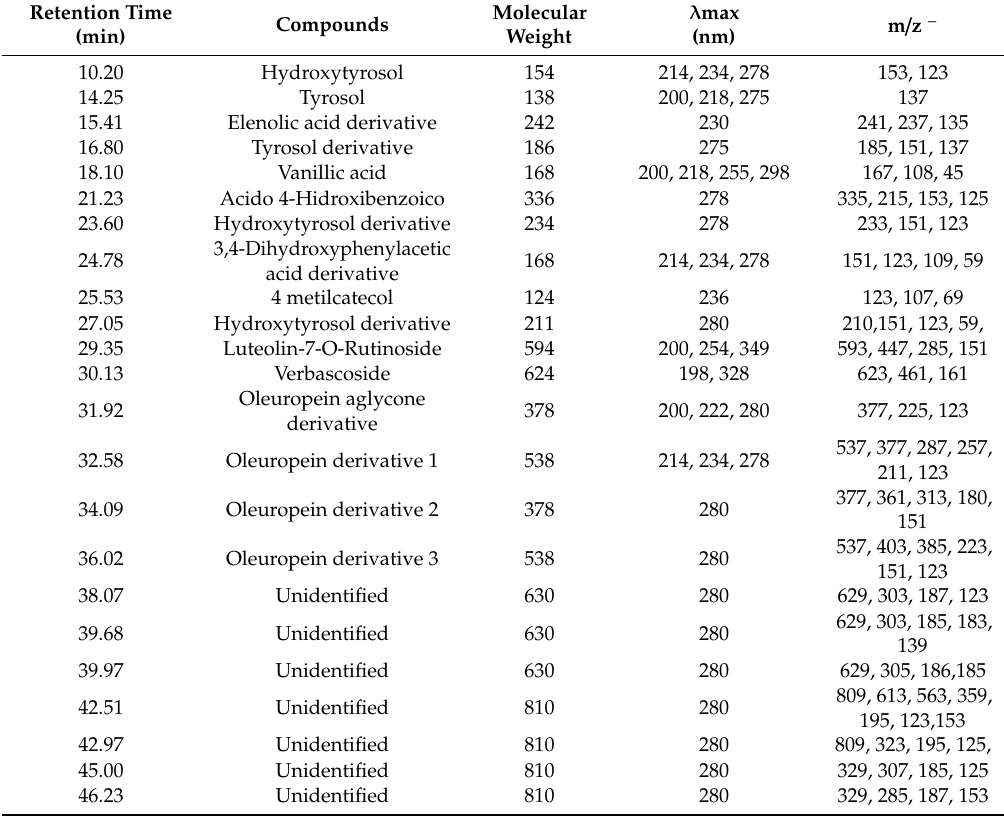
Table 3. Phenolic compounds identified by HPLC-DAD-MS in the fraction obtained from the phenolic extract by the ionic resin column in comparison to the results obtained by Rubio-Senent et al. [22].